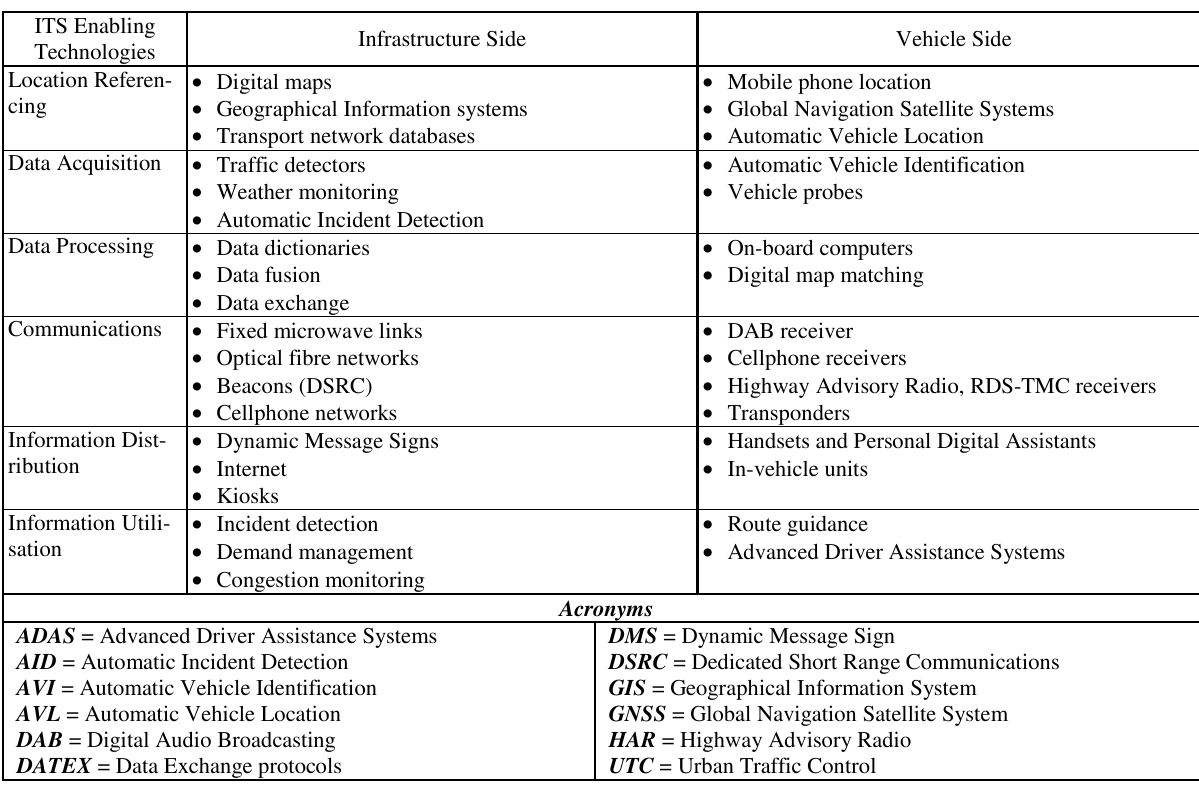
Table 1. ITS enabling